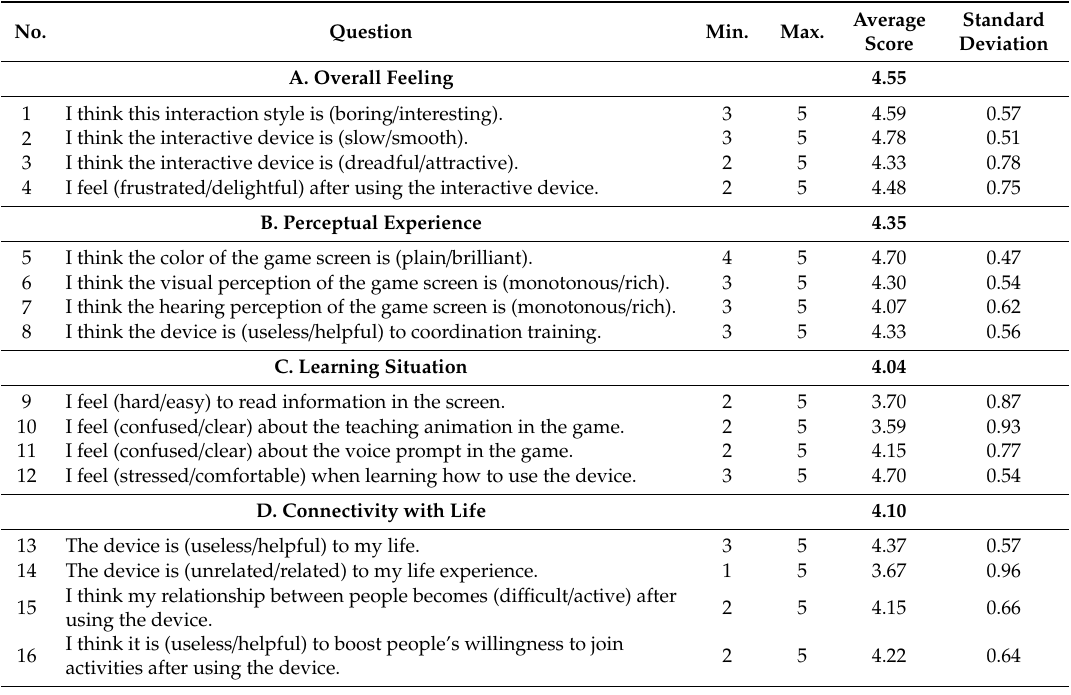
Table A5. Questions about user interaction satisfaction in the questionnaire and statistics of the average scores of the answers to the